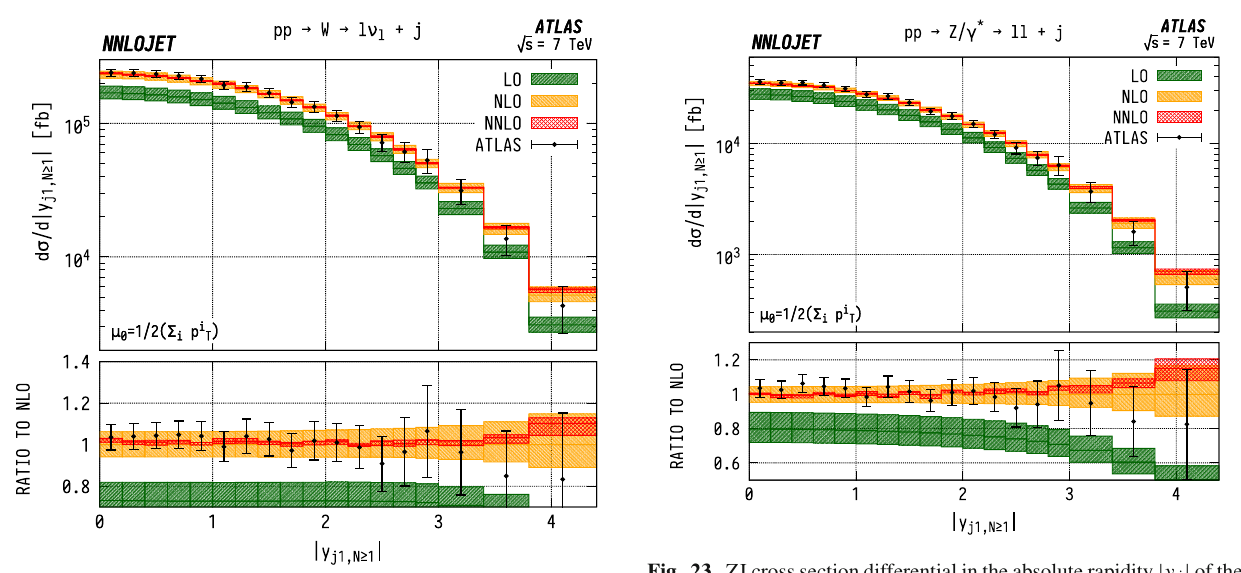
Fig. 22 WJ cross section differential in the absolute rapidity | y j | of the leading jet. See Fig. 14 for details